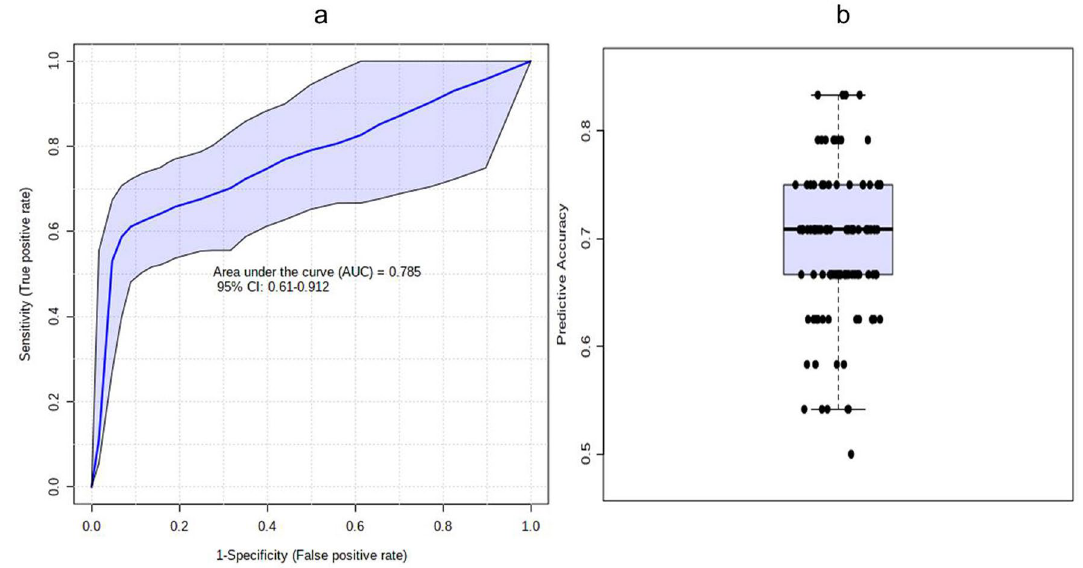
Figure 8. ( a ) The predictive ability of the combination of Anthranilate, 3-Hydroxykynurenine, Tyrosine, and 5-Hydroxytryptophan based on ROC AUC values along with with Sensitivity and Specificity at 95% CI. ( b ) The average predictive accuracy of the metabolite combination based on 100 cross validations.